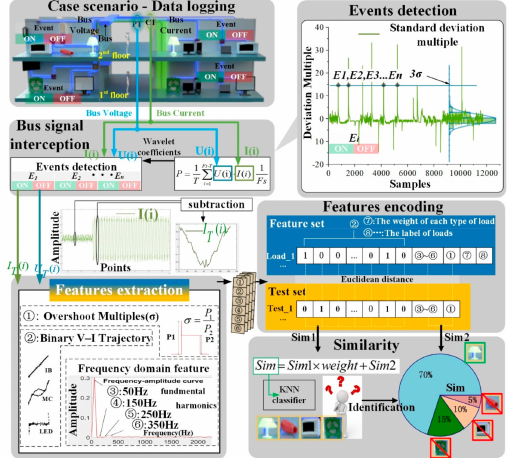
Figure 1. The methodology of NILM with sparse sample and real-time